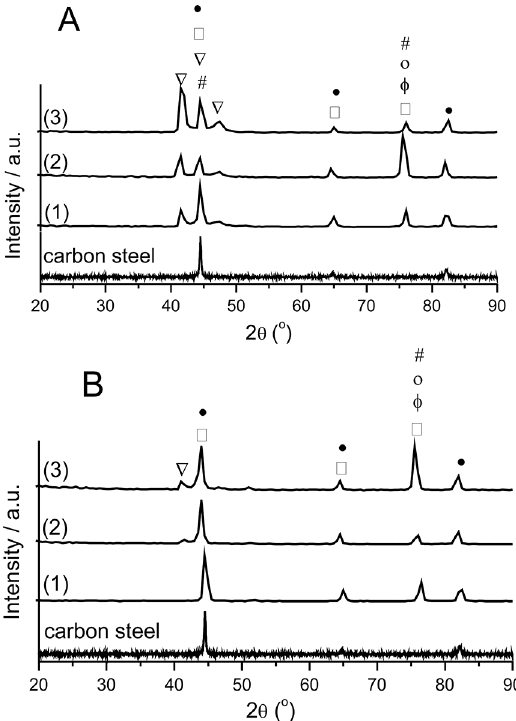
Figure 1. XRD patterns of coatings obtained using Solution 1 (A) and Solution 2 (B) under the conditions described in Table 1: (1) Experiment 1; (2) Experiment 2; (3) Experiment 3. Legend: • Fe; ϕ Co; ○ Ni; # NiCo alloy; □ NiCo